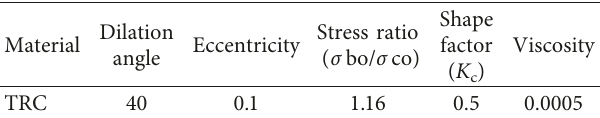
Figure 9: Stress-strain diagram of TRC in tension and compression implemented in Table 2: CDPM parameters.